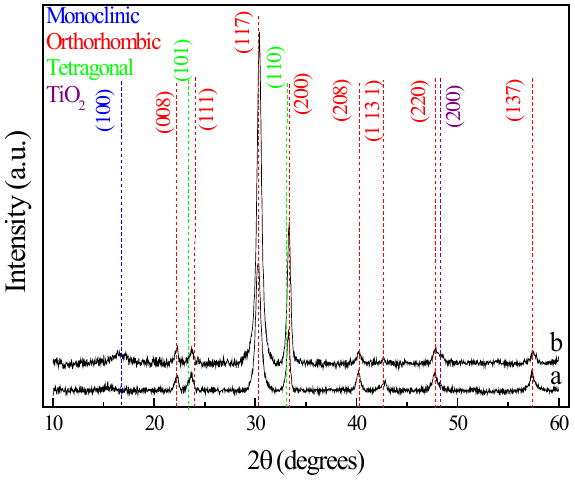
Figure 3. XRD patterns of bismuth titanium oxide thin films with annealing treatment in ( a ) oxygen; and ( b ) dry air atmospheres.